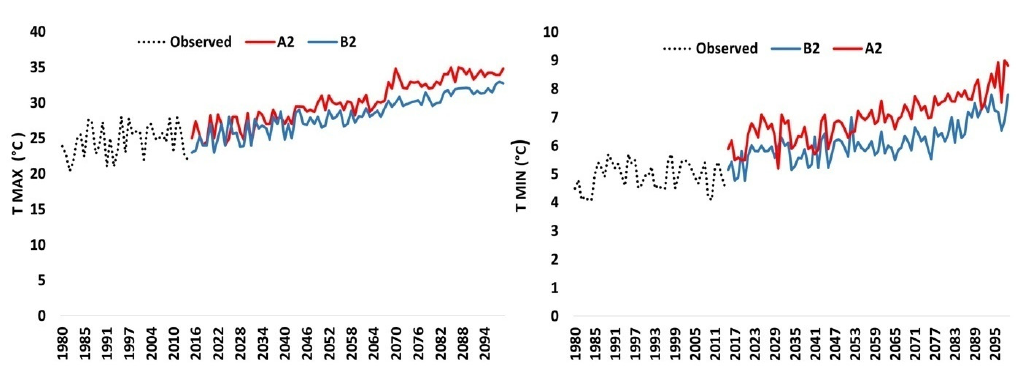
Figure 4. Projected precipitation for the future period until 2100.